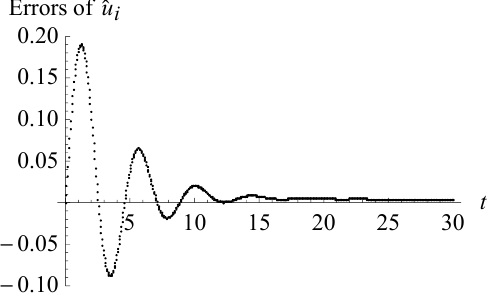
Figure 2. The errors of the L 1– L 2 numerical solutions ˆ u i ( h =